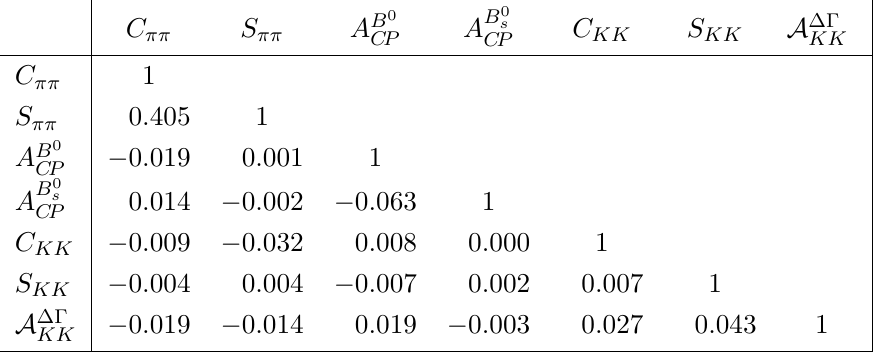
Table 5 . Correlation matrix for the CP violation parameters obtained from the combination with Run-1